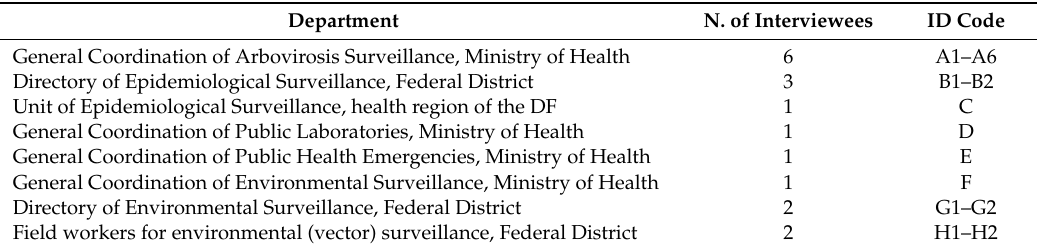
Table 1. List of participants in the study. The identification (ID) code has been used to refer to the content of the interviews in the result